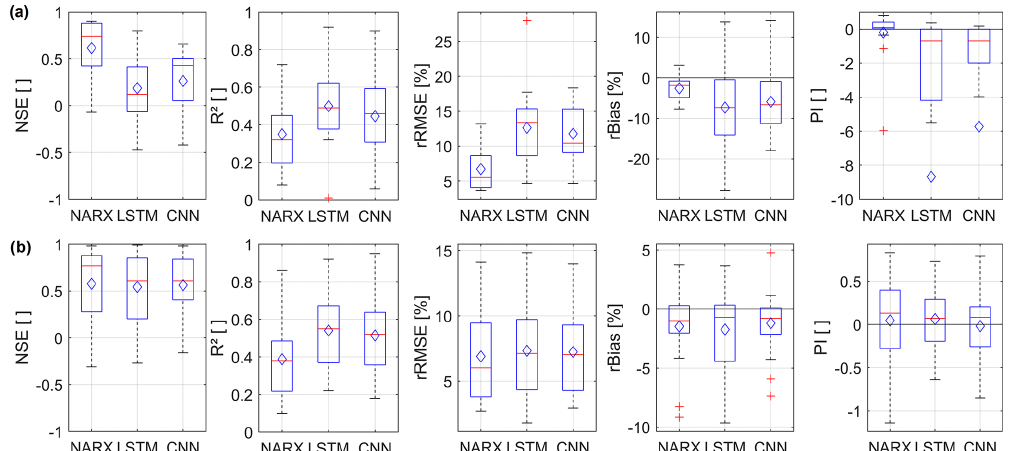
Figure 7. Boxplots showing the seq2seq forecast accuracy of NARX, LSTM, and CNN models within the test period (2012–2016) for all considered 17 hydrographs. The diamond symbols indicate the arithmetic mean; (a) only meteorological inputs; (b) GWL t − 1 as additional